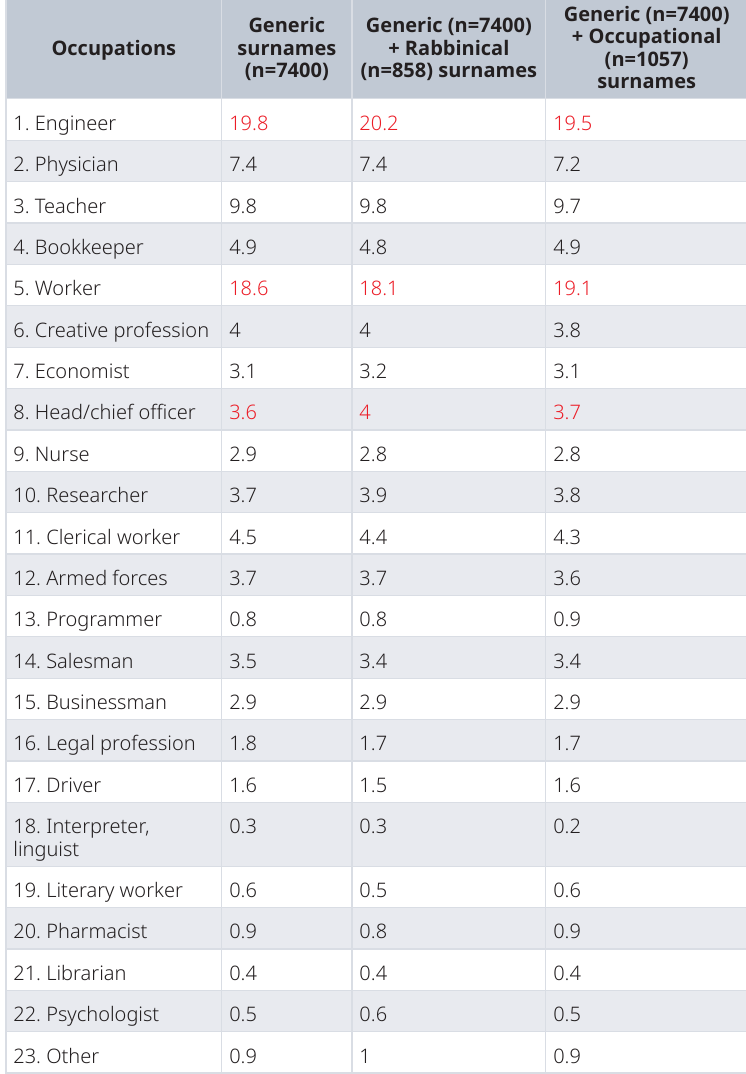
Table 6. Occupational distributions for different sections of the considered group of Russian-speaking Jews, only means shown. The second column provides the distribution of the generic surnames (considered previously), the third gives the distribution for the joined classes of generic and rabbinical surnames and the fourth for generic and occupational